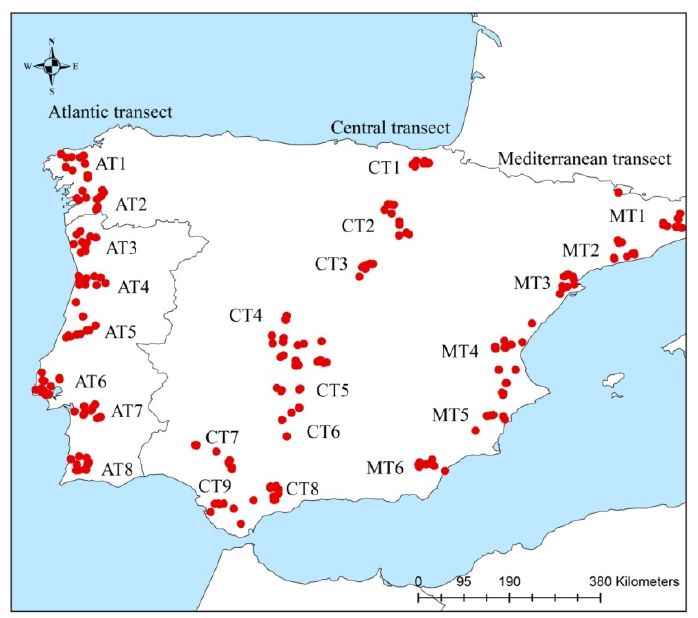
Figure 1. Geographical location of 711 colonies sampled in the Iberian Peninsula.